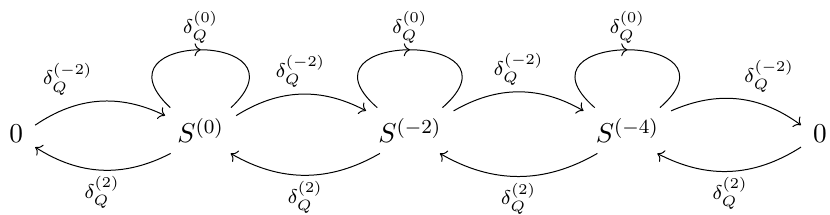
Figure 2 . Schematic representation of (3.7). The diagram shows that different orders in the expansion (3.1) mix under supersymmetry δ Q , according to the rules: the sum of all arrows ending at a certain order S ( i ) vanishes. This gives rise to